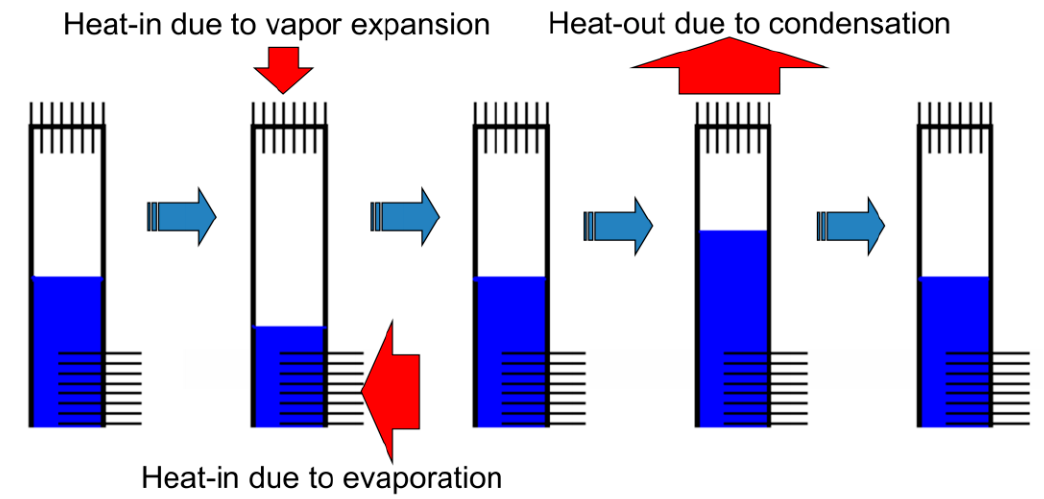
Figure 5. Condition unit working principle.